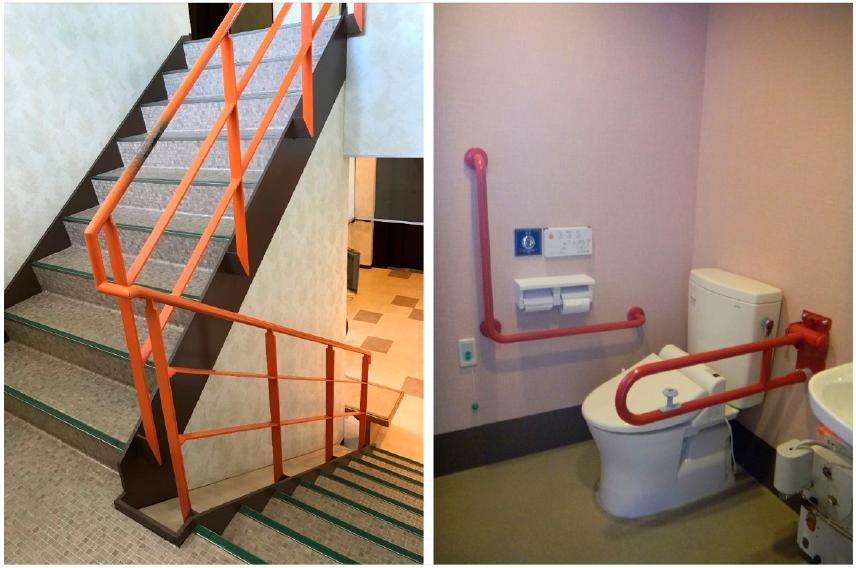
Figure 13. Red or orange handrails in Sawayaka Town.